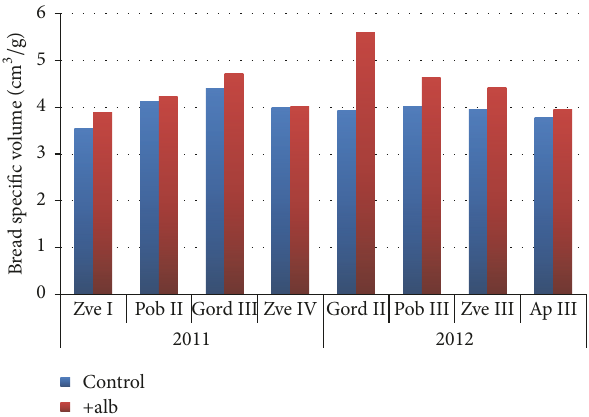
Figure 4: Comparison of specific volume of bread samples pro- duced with increased total albumin content with control samples from both production